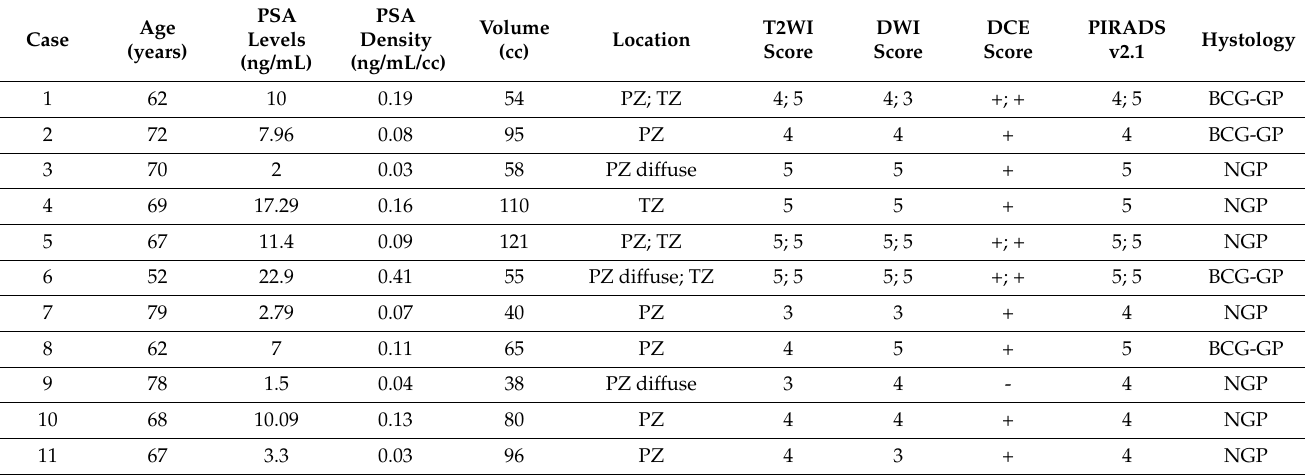
Table 1. Clinical parameters and main MR Imaging Features of GPs in 11